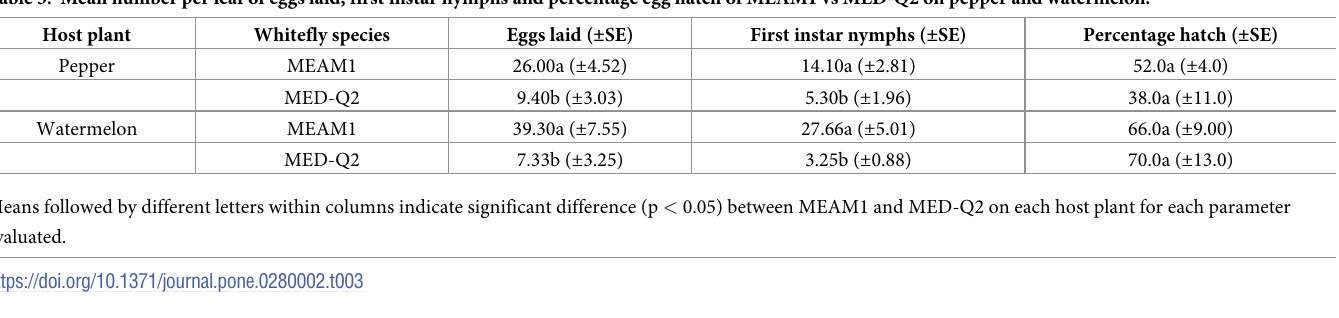
Table 3. Mean number per leaf of eggs laid, first instar nymphs and percentage egg hatch of MEAM1 vs MED-Q2 on pepper and watermelon. Host plant